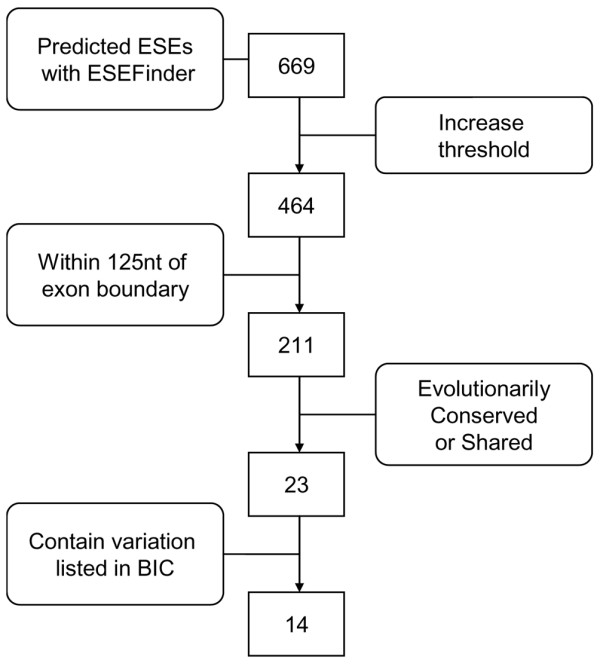
Prioritizing ESEs in the coding region of BRCA1. Shown is a flow diagram of the process of prioritizing exonic splicing enhancers (ESEs) in the BRCA1 open reading frame for biochemical analysis. Numbers indicate predicted ESEs following each stage.